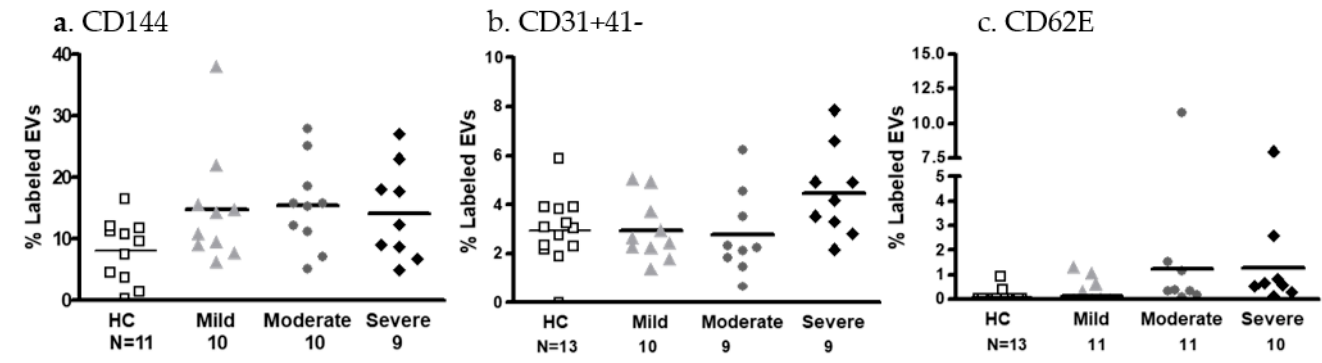
Figure 3. EV endothelial cell markers. The expression of endothelial cell markers on EVs derived from HC PPP and mild, moderate, and severe COVID-19 patients was measured by a CytoFLEX LX flow cytometer. The percentage of labeled EVs was calculated from the total number of EV counts in the vesicles EXo gate, set by the mega-mix beads. The graphs present the percentage of EVs expressing CD144 (VE-Cadherin) ( a ), PECAM-1 (CD31 + CD41-) ( b ), and E-selectin (CD62E) ( c ).